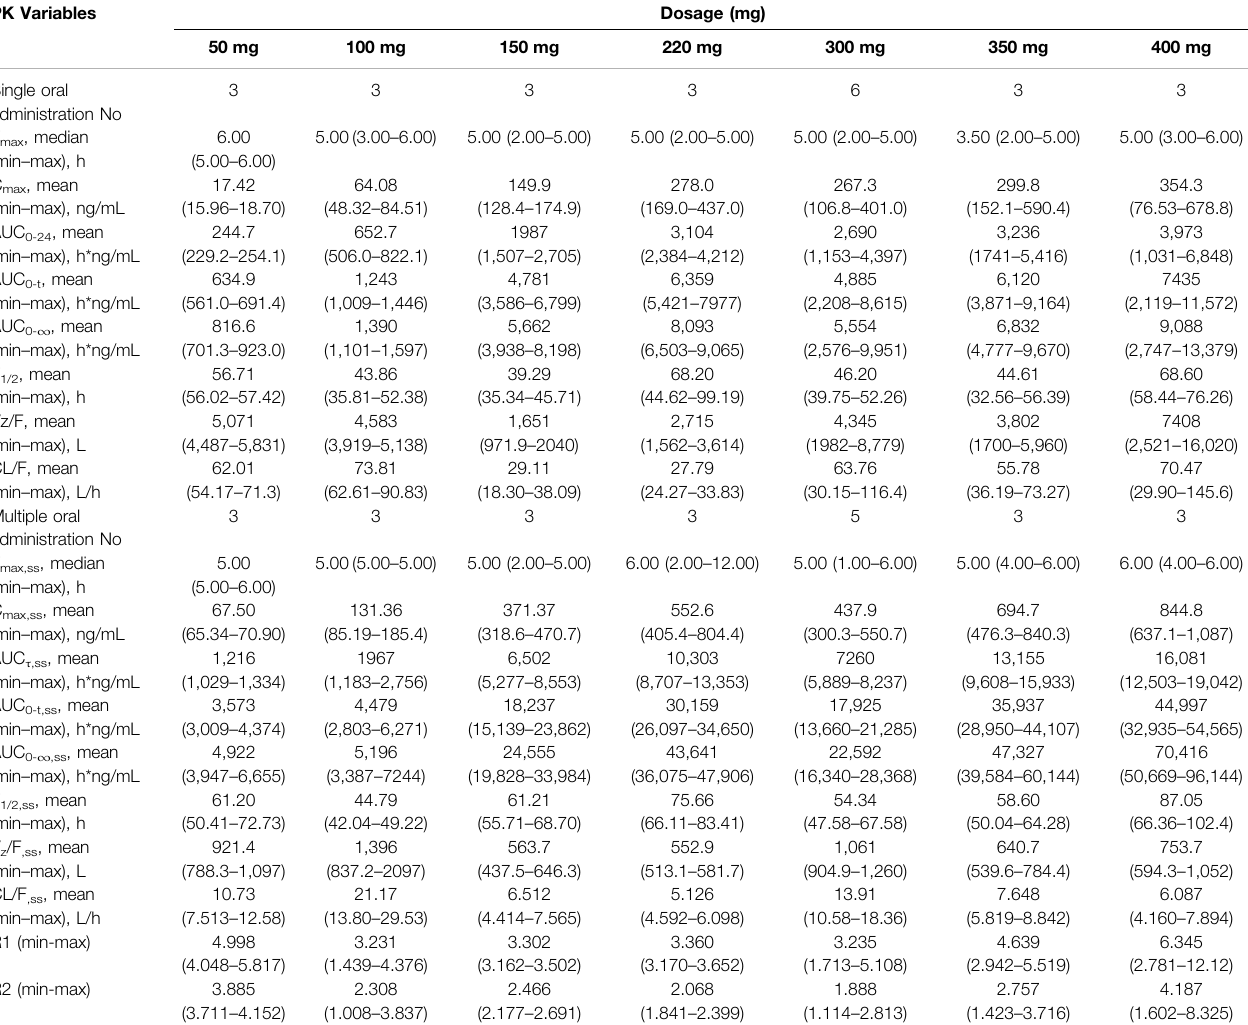
TABLE 3 | Pharmacokinetic (PK) properties of larotinib after oral administration of single and multiple doses of 50-, 100-, 150-, 220-, 300-, 350- and 400-mg larotinib mesylate